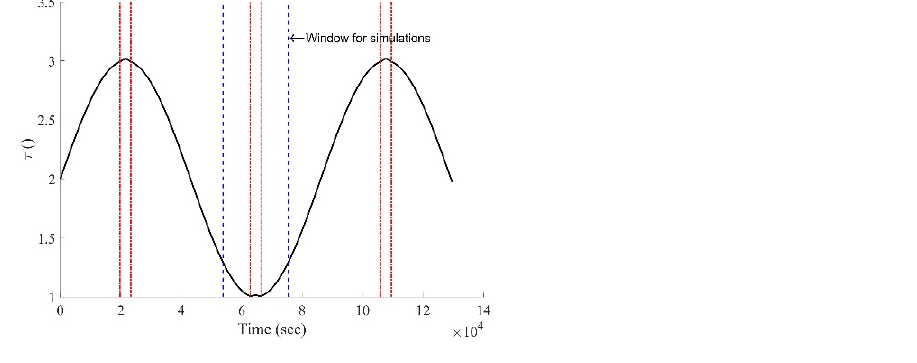
Figure 7. Development of 𝜏 over time; the influence of the turn of tide parameter ∆𝑆 is marked by the red dotted lines; the simulations described above are taking place during the time window between the blue lines.